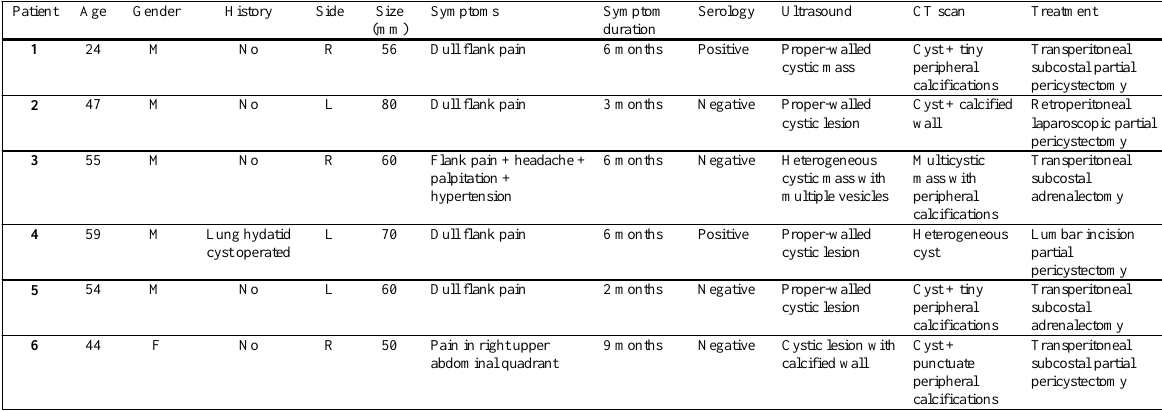
Table I: Summary of clinical and radiological data of our six patients